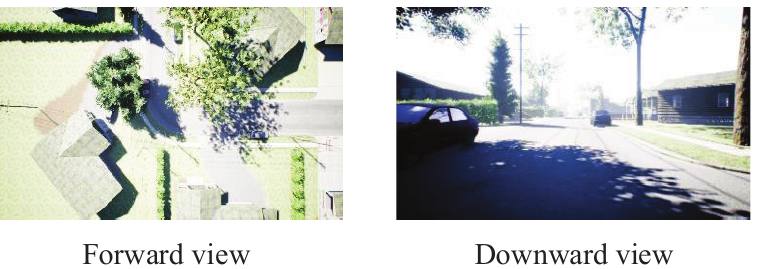
Figure 4. The samples of forward view and downward view images in the Airsim dataset. They are sampled from the same location.